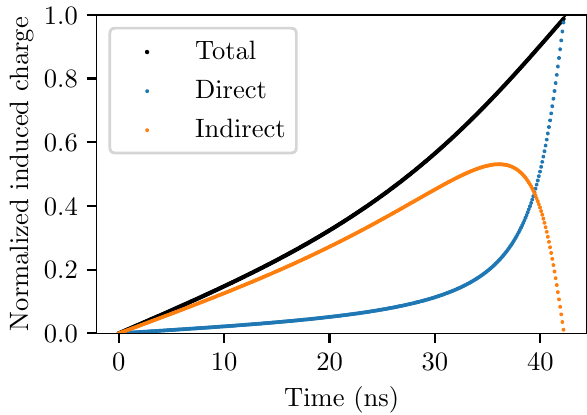
Fig. 19 A simulation of induced charge development on a pixel of the BEAST TPCs, using the Shockley-Ramo theorem and assuming a uniform charge distribution with no diffusion. Direct charge is induced by charges drifting to the pixel, while indirect charge is induced by charge drifting to neighboring pixels. The charge drifts over the 2 . Fig. 18 A 2D histogram of σ 2 vs. σ 2 using the beam-on dataset with L T E > 100 keV and 75 ◦ < θ < 105 ◦ . The orange line shows the apparent linear relationship in the distribution, and has an offset of − 0 . 04 mm 2 and a slope of 1.5